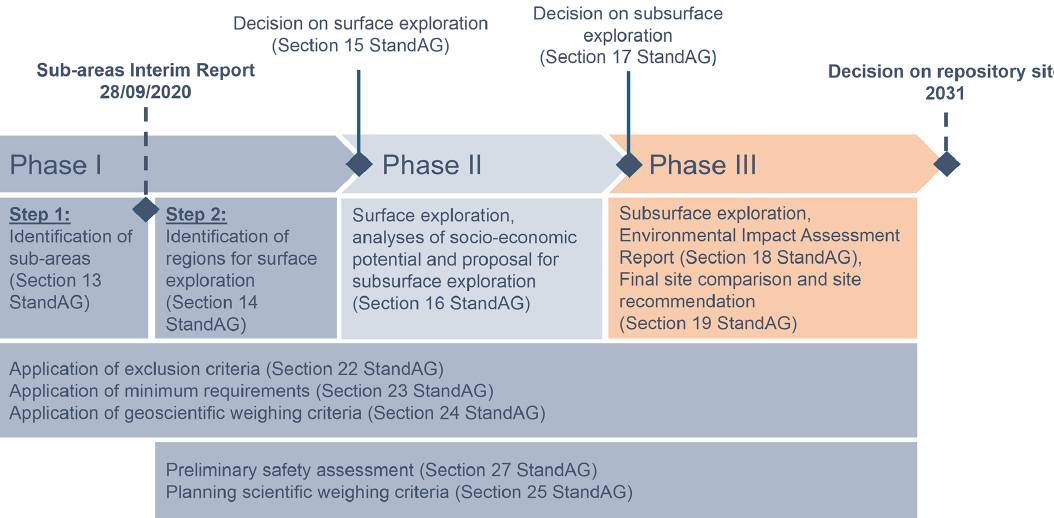
Figure 1. Schematic overview of the three phases of the site selection procedure in Germany according to the Repository Site Selection Act (BGE,